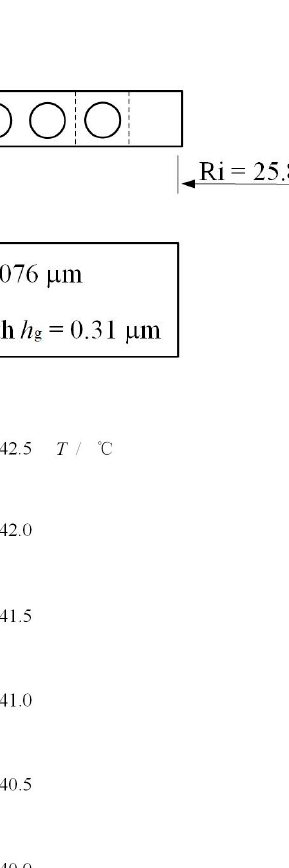
Figure 2. Textured seal ring with circle-dimples.